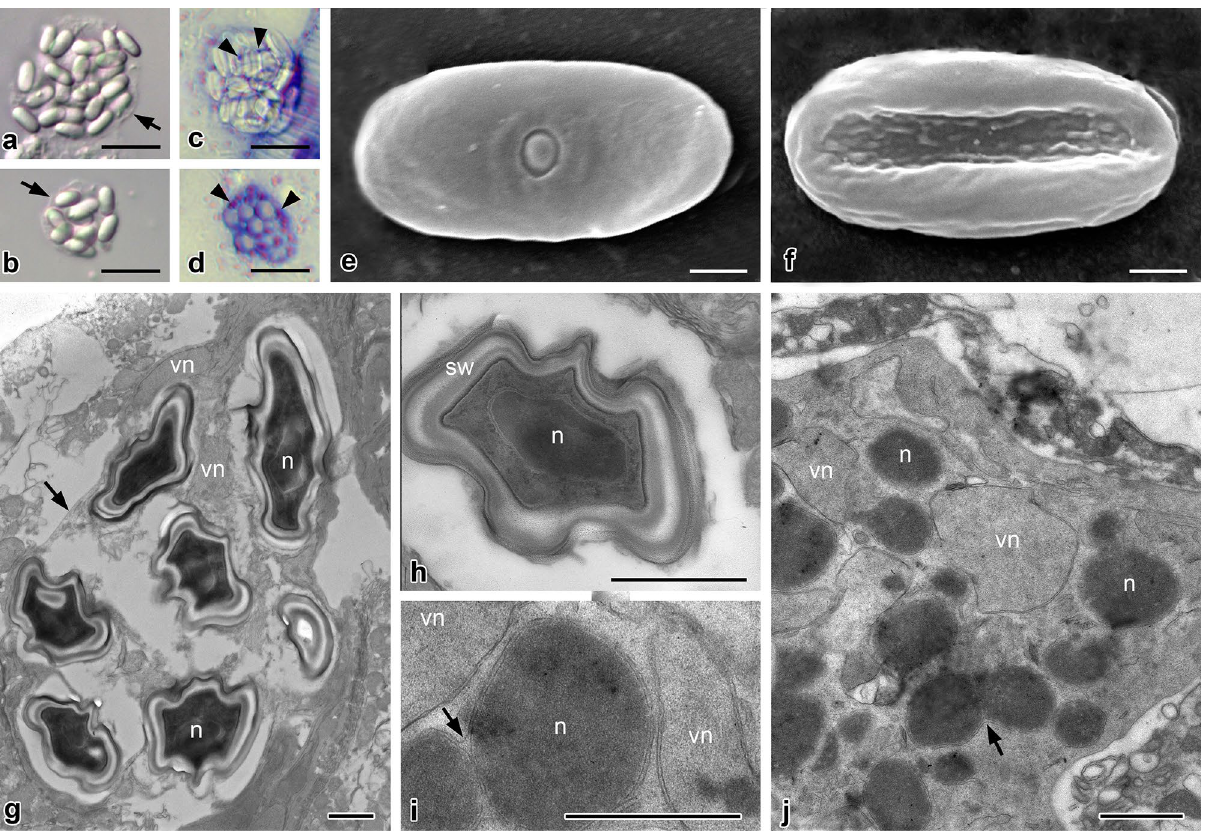
Figure 2. Nephridiophaga javanicae sp. nov. from Elliptorhina javanica . ( a , b ) Sporogenic plasmodia including different numbers of mature spores. Arrows point to plasma membranes of the plasmodia. ( c , d ) Giemsa staining reveals vegetative nuclei (arrowheads) of sporogenic plasmodia. ( e , f ) Scanning electron micrographs of dorsal ( e ) and ventral ( f ) side of flattened, mature spores. Dorsal side with central cap of spore opening. ( g – j ) Ultra- thin sections. ( g ) Sporogenic plasmodium with electron-dense mature spores and vegetative nuclei (vn). Spores contain one nucleus (n). Arrow points to plasma membrane of plasmodium. ( h ) Mature spore in cross-section. Spore wall (sw) consists of several layers. ( i , j ) Vegetative plasmodia with vegetative electron-light nuclei (vn) and prospective electron-dense spore nuclei (n). Arrows point to division or fusion of electron-dense nuclei (note outer membrane surrounding both nuclei). Scale bars: (a–d) = 10 µm, (e–j) = 1 spores, residual vegetative nuclei of the mother plasmodia are visible (Figs. 1d, 2c,d). Single mature spores are flattened, oval-shaped (Fig. 1c), and measure 5.0–7.0 × 2.6–3.8 µm (mean 5.9 × 3.2 µm; n = 52) in N. postici and 5.3–7.1 × 2.7–3.8 µm (mean 6.4 × 3.3 µm; n = 42) in N. javanicae . Scanning electron microscopy revealed flattened spores with a thickened rim (Figs. 1g,h, 2e,f). One side pos- sesses a small, central cap (spore opening; Figs. 1g, 2e; the dorsal side according to Radek and Herth 8 ) while the other (ventral) side misses such a structure but shows tiny bulges. Longitudinal folds may occur as preparation artifact during drying (Figs. 1g, 2f). Between the electron-dense mature spores of sporogenic plasmodia, residual vegetative nuclei are seen in ultra-thin sections (Fig. 2g). Mature spores contain one central nucleus (Fig. 2g, h). The spore walls are thick at the rim and thinner at the flat sides and the spore opening (Fig. 1j). They consist of several layers (Figs. 1i,j, 2g,h); in addition to outer and inner biomembranes, the outer and inner layers of the wall are electron-dense and the zone in-between has a moderate electron density. Before visible spores are formed within a plasmodium, two types of nuclei develop, which differ by electron density (Fig. 2i,j). Since the residual vegetative nuclei in mature sporogenic plasmodia are electron-light (Fig. 2g), the electron-light nuclei in young sporogenic plasmodia (Fig. 2i,j) most likely also represent vegetative nuclei while the dense forms represent the future spore nuclei. Whereas the described morphological characteristics of N. postici and N. javanicae were less discriminative, our molecular phylogenetic analyses (below) confirmed that they are two distinct species. Affiliation of nephridiophagids to Chytridiomycota. To place nephridiophagids within the fungal tree of life, we incorporated all major fungal groups in our analyses. The phylogenetic tree (Fig. 3) inferred from a concatenated alignment of SSU and LSU rRNA genes reveals overall good support for the diverse phyla (for a current overview, see Wijayawardene et al. 24 ). Nephridiophagids fall into the phylum Chytridiomycota, branch- ing as sister to species that belong to the Cladochytriales (support 89%, 95%, 0.89; see Fig. 3). This topology is